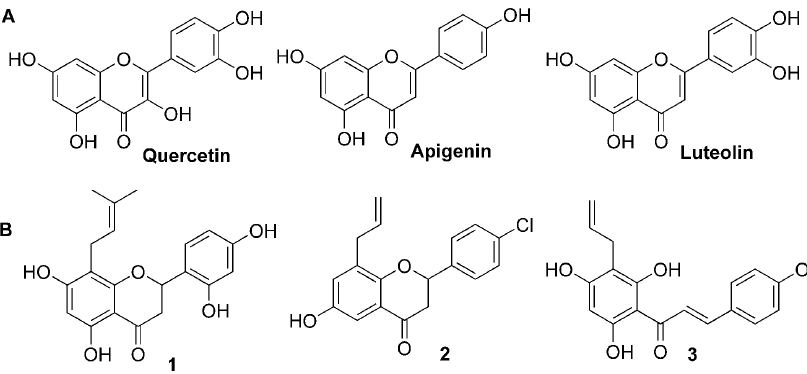
Figure 1. The 2D structure of the flavonoids with potent vasorelaxant